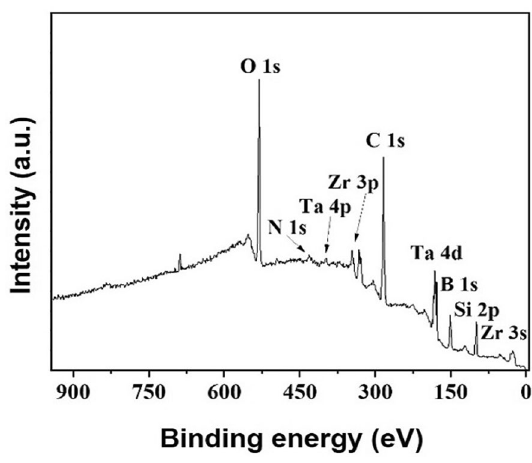
Figure 4. XPS analysis of ZrB 2 -SiC-TaN